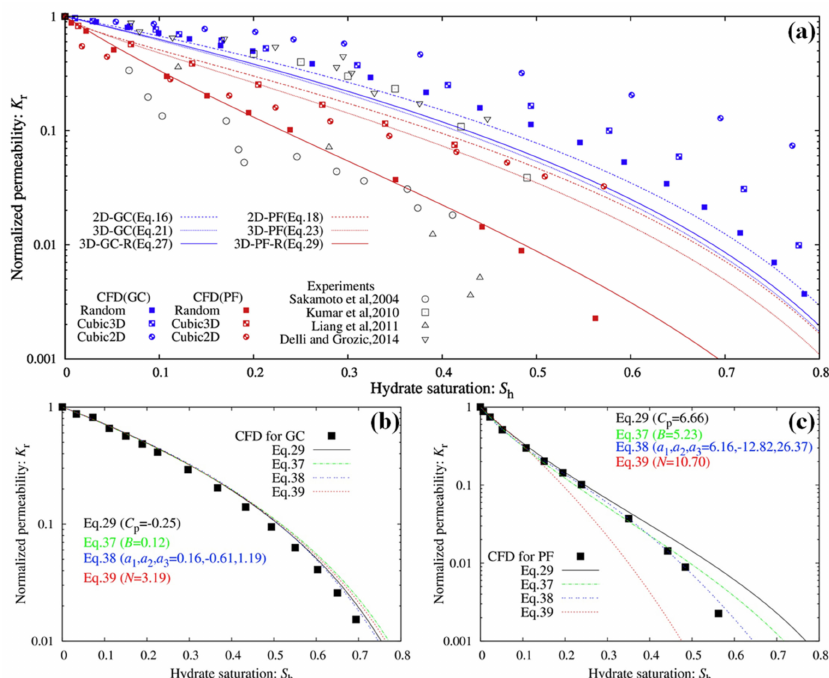
Figure 9. Relation between hydrate saturation and the normalized permeability [54]. ( a ) Compari- son between simulated K n from Katagiri et al. CFD simulations, calculated K n from Katagiri et al. analytical models, and experimental results from previous studies [24,82,95,99]. ( b , c ) Prediction performances of the Katagiri et al. analytical models and other existing permeability reduction mod- els [40,42,53]. Reprinted from Journal of Natural Gas Science and Engineering, Vol. 45/pages 537–551, Katagiri et al. Pore-scale modeling of flow in particle packs containing grain-coating and pore-filling hydrates: Verification of a Kozeny-Carman-based permeability reduction model, Copyright (2017), with permission from